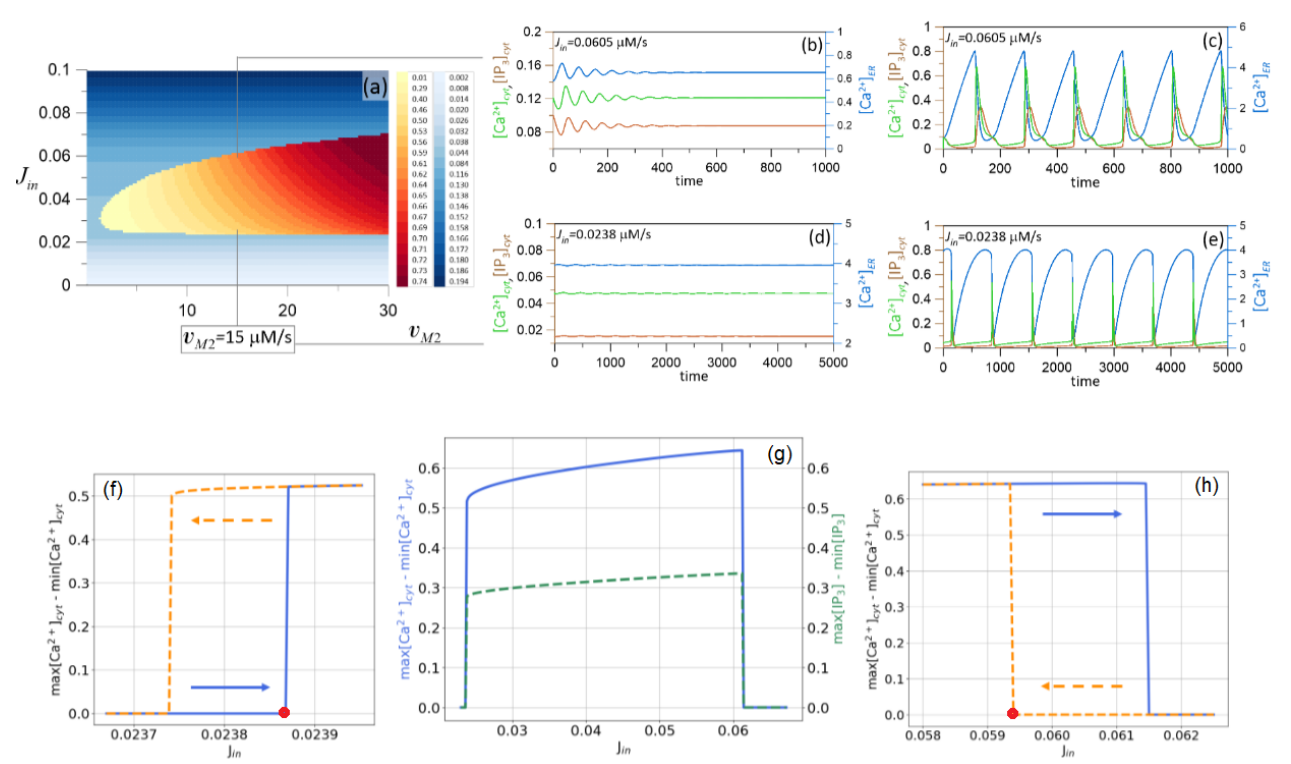
Figure 4. ( a ) Two-parametric diagram obtained for [ Ca 2 + ] cyt and various values of v M 2 and J in parameters. As in Figure 3a, the intensity of the blue demonstrates the change of [ Ca 2 + ] cyt in the equilibrium. The difference between the minimal and the maximal value of [ Ca 2 + ] cyt in the oscillatory regime is shown by the red-to-yellow gradient. For v M 2 = 15 µ M/s, the coexisting regimes observed near the upper boundary of the oscillations-to-quiescence transition are shown in ( b , c ), near the lower boundary—in ( d , e ). In ( g ), the difference between the minimal and the maximal value of [ Ca 2 + ] cyt is shown by a blue curve, and the difference between the minimal and maximal value of [ IP 3 ] cyt is shown by a dashed green curve. In ( f , h ), the widths of the bistable ranges are presented for lower and upper boundaries, respectively. The blue curve shows the data obtained with the increase of J in , while the dashed orange curve was calculated with the decrease of J in